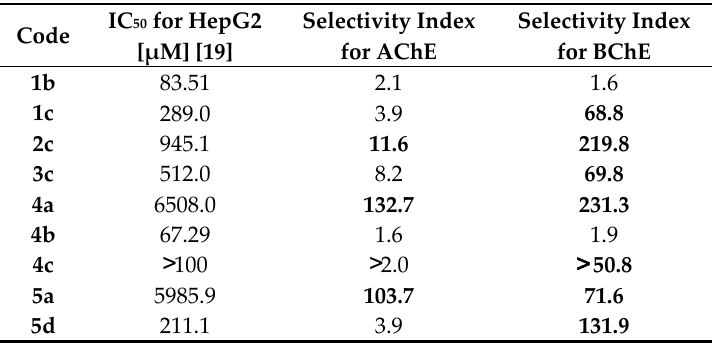
Table 2. Cytotoxicity and selectivity indexes for selected (thio)carbamates.